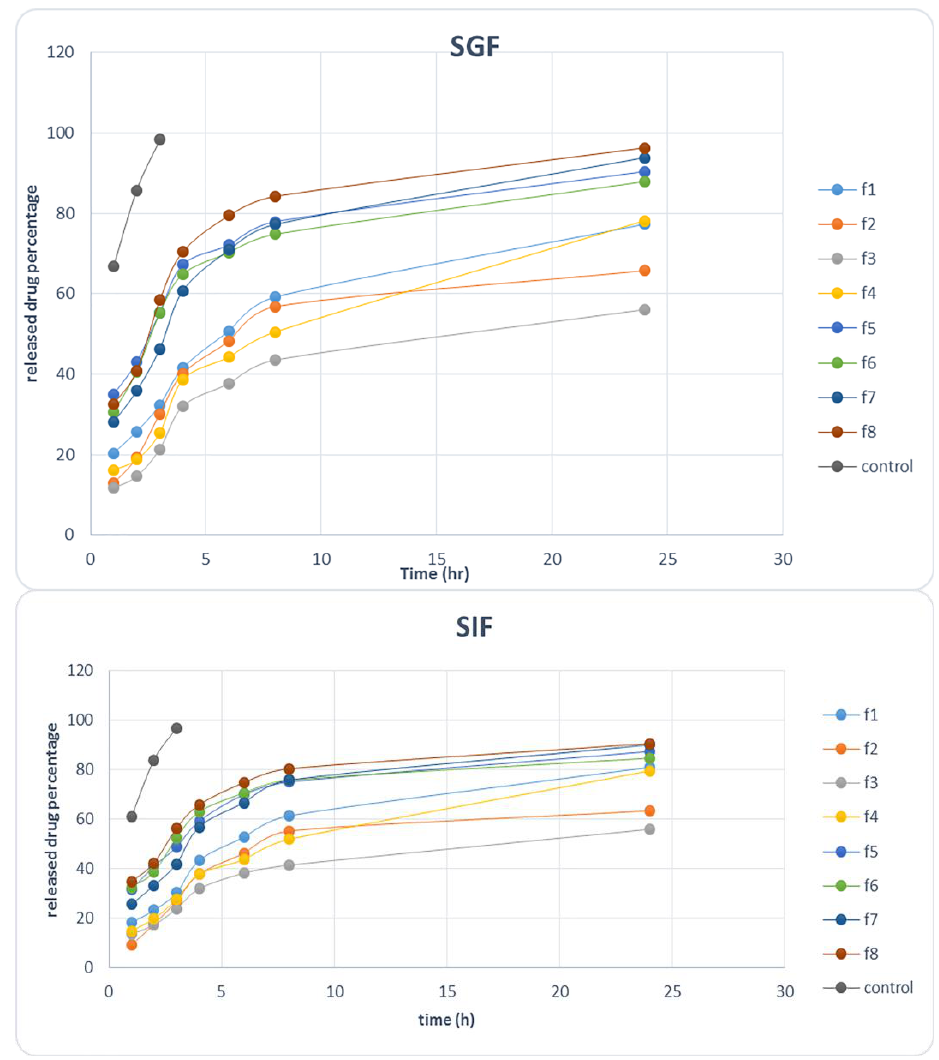
Figure 2. Released ciprofloxacin percent against time in SGF and SIF solutions.